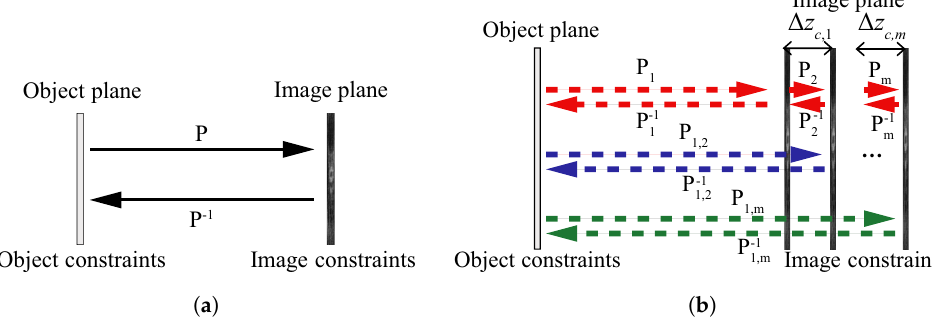
Figure 13. Iterative phase retrieval with ( a ) one single and ( b ) multiple depth